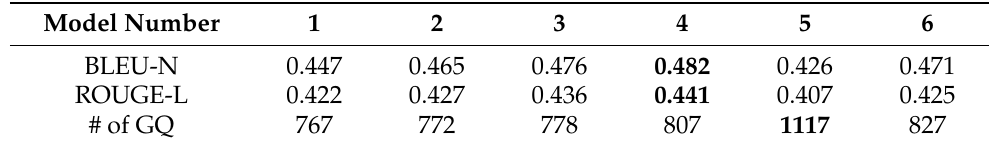
Table 2. Performance Evaluation for Each Single T5 Model.